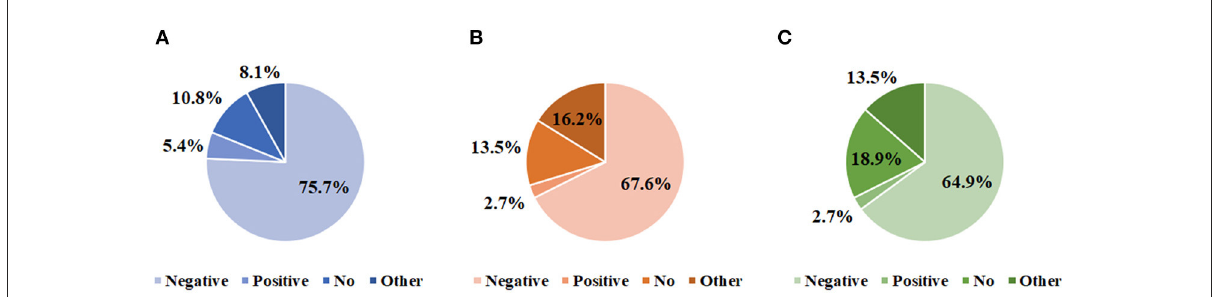
FIGURE1 Experiences and perspective of oncologists regarding the impact of COVID-19. The extent to which COVID-19 affected clinical work routine in oncology (A) , personal daily lives (B) , and palliative care practice (C) .